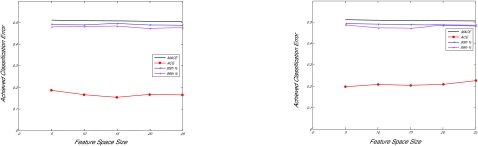
PACE analysis using a SVM-based classifier using the weighted separability scoring criterion, with a 0.6 MAC threshold. Left Panel: performance without peak selection. Right panel: performance with peak selection.